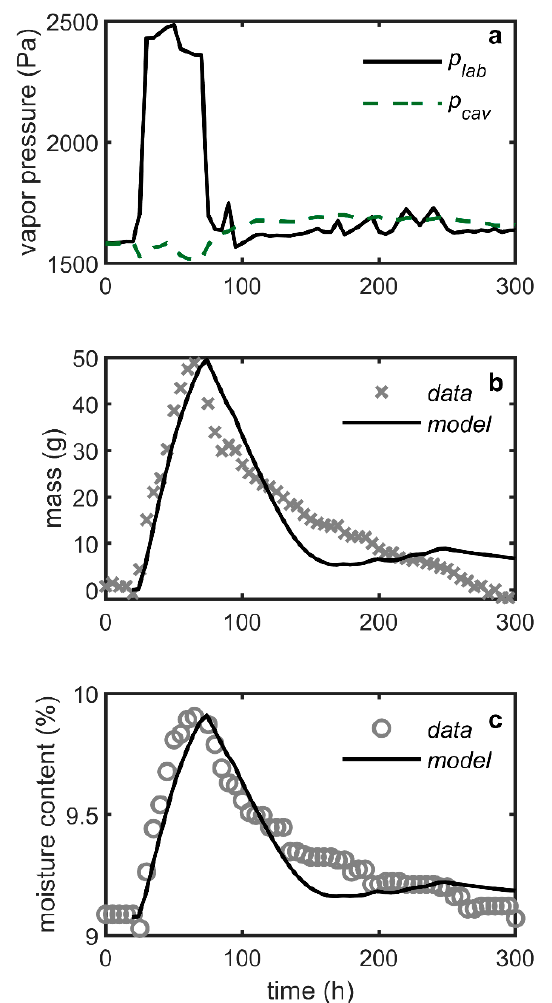
Figure A2. Laboratory conditions ( a ) and associated mass response ( b ) and MC response ( c ) during RH spike, showing sorption model fit.